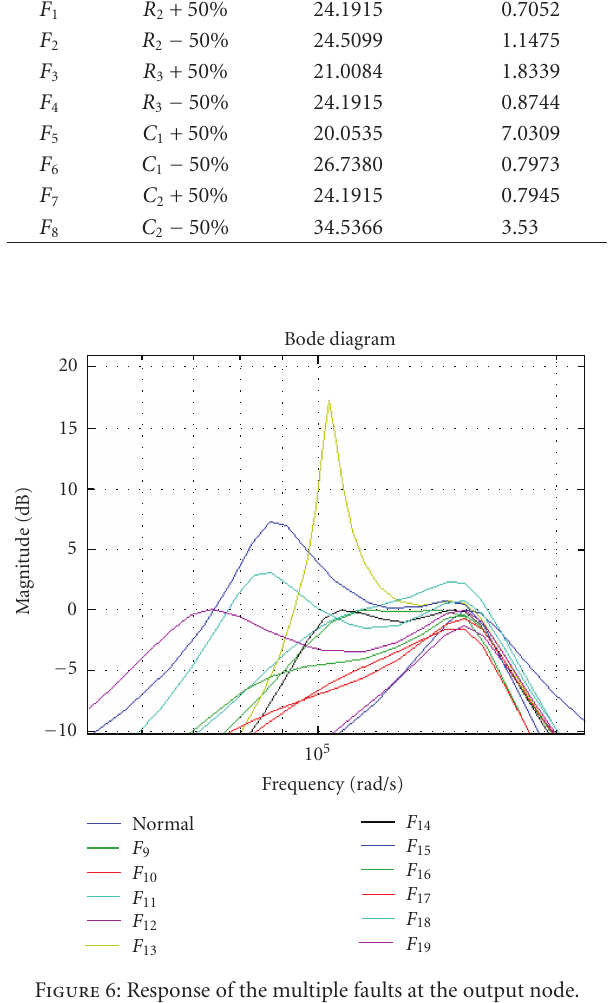
Figure 6: Response of the multiple faults at the output node.